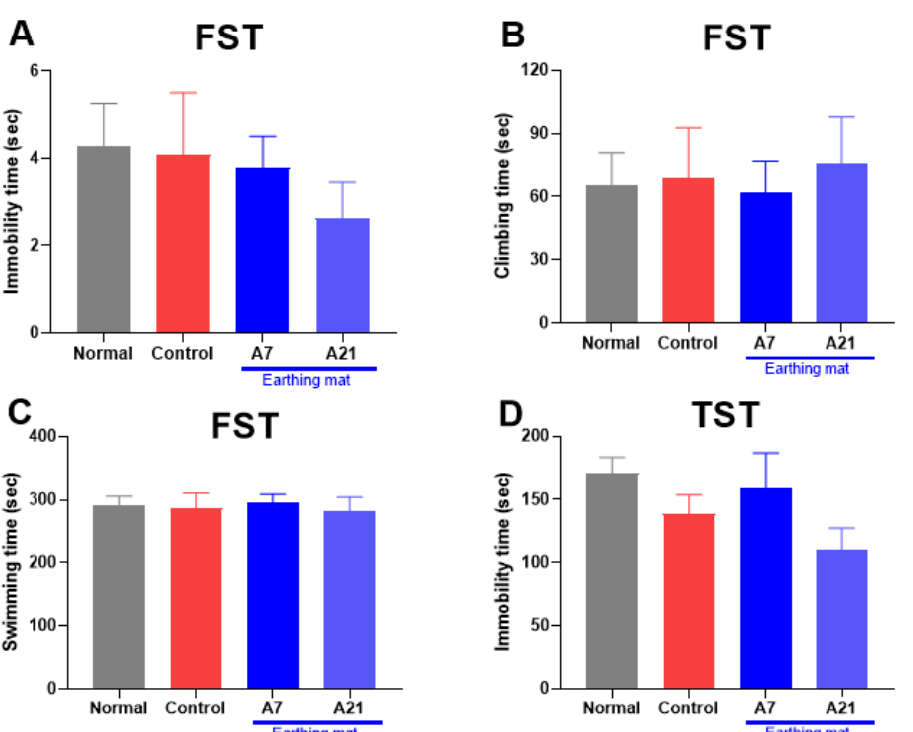
Figure 3. Effect of earthing mat on the FST ( A – C ) and TST ( D ). Data represent means ± SEM.